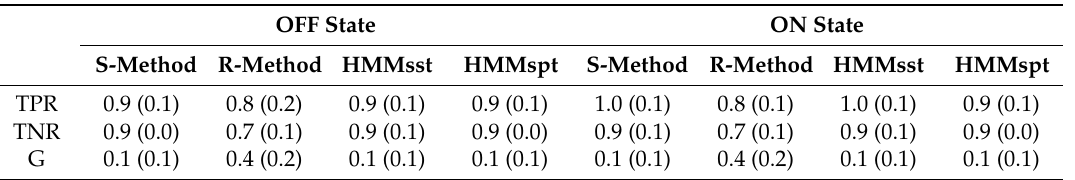
Table 3. Mean and standard deviation of True Positive Rate (TPR), True Negative Rate (TNR) and Goodness index (G) of all methods both in OFF and ON state of right